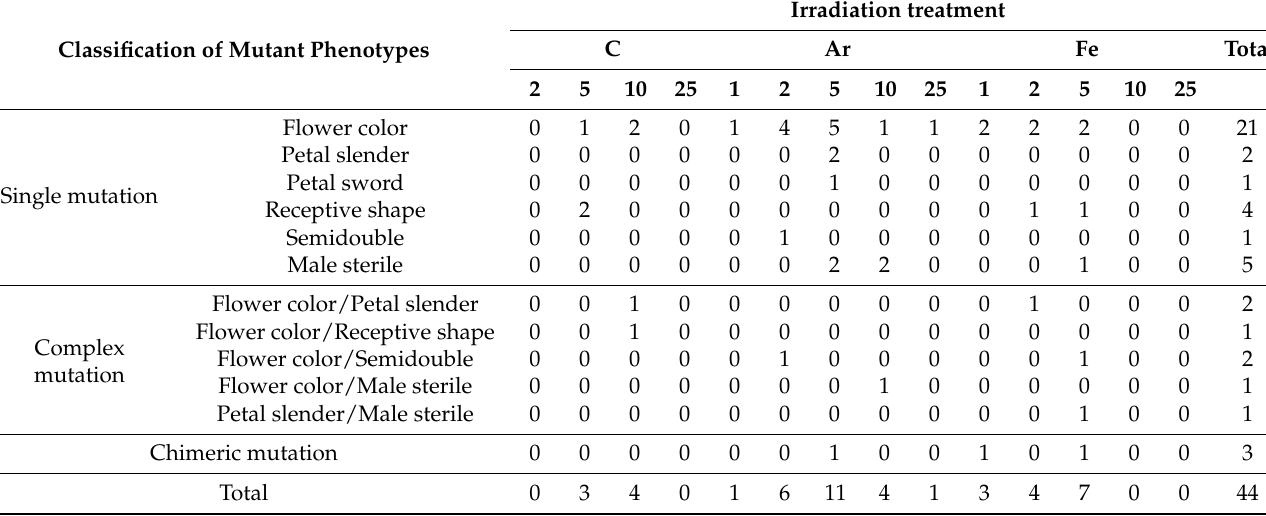
Table 1. Number of mutants with trait/morphological mutations obtained by ion beam irradiation with 2363 plants.